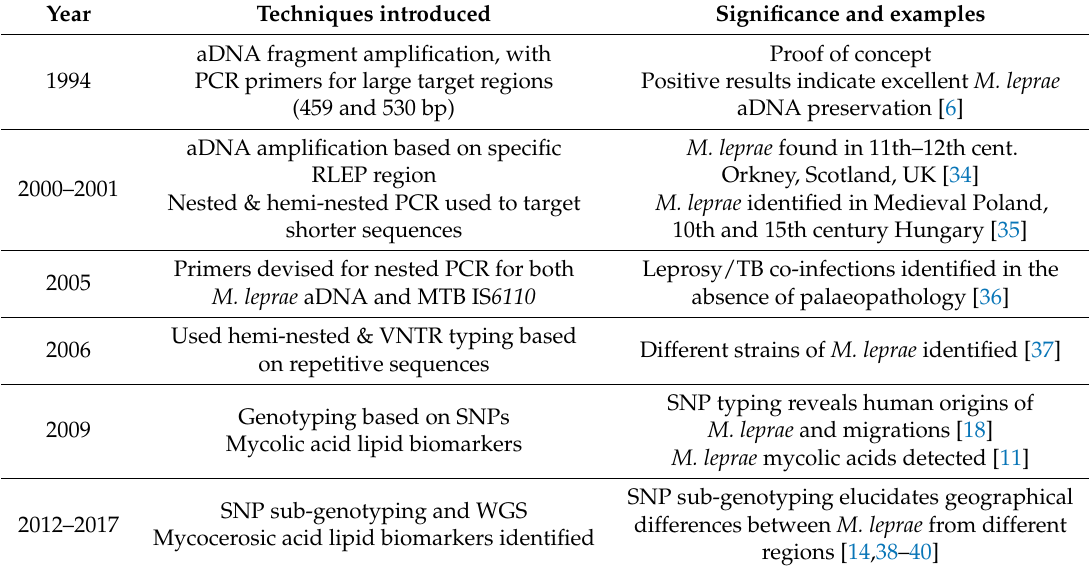
Table 2. Summary of methods used in M. leprae aDNA and lipid biomarker diagnoses (see Table S2 for detailed